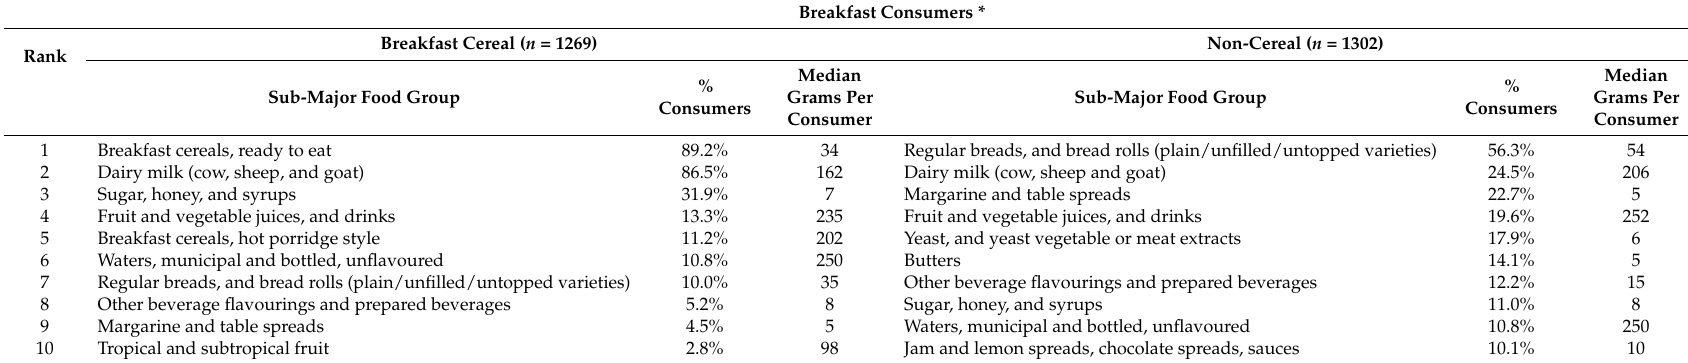
Table 2. Top 10 sub-major food groups consumed at breakfast ranked by prevalence of consumption amongst cereal and non-cereal consumers aged 2–18 years based on the 2011–2012 National Nutrition and Physical Activity Survey ( n =